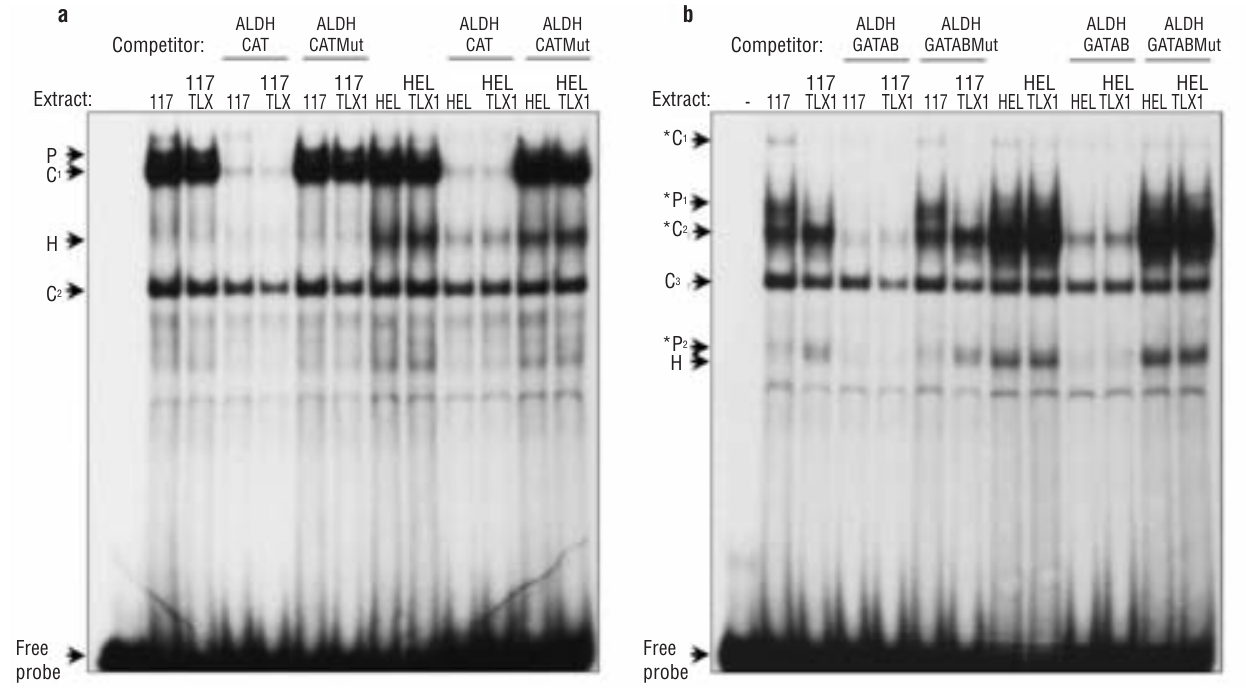
Figure 4. Effect of TLX1 on ALDH1A1 promoter DNA-binding complexes. (A) TLX1 does not affect DNA-protein complex formation at the -74 CCAAT box. EMSA using a 32 P-labeled double-stranded oligonucleotide containing the CCAAT site at -74 of the human ALDH1A1 promoter (ALDH CAT). The assay was performed with nuclear extracts prepared from PER-117 (left lanes) or HEL cells (right lanes) with and without overexpression of TLX1. The migration of the free probe is indicated along with the positions of specif- ic DNA-protein complexes (C1 and P in PER¬117 cells; C1 and H in HEL cells). Overbars denote the addition of a 35-fold molar excess of unlabeled double-stranded self (ALDH CAT) or mutant (ALDH CATMut) probe as competitor. (B) TLX1 alters DNA-pro- tein complex formation at the -33 GATA box. EMSA performed as above using a labeled oligonucleotide containing the GATAAA site at -33 of the human ALDH1A1 promoter (ALDH GATAB). The migration of the free probe is indicated along with the positions of specific DNA-protein complexes (C1, C2, P1 and P2 in PER-117 cells; C1, C2 and H in HEL cells). Overbars denote the addition of a 35-fold molar excess of unlabeled double-stranded self (ALDH GATAB) or mutant (ALDH GATABMut) probe as competitor. Asterisks denote complexes altered by